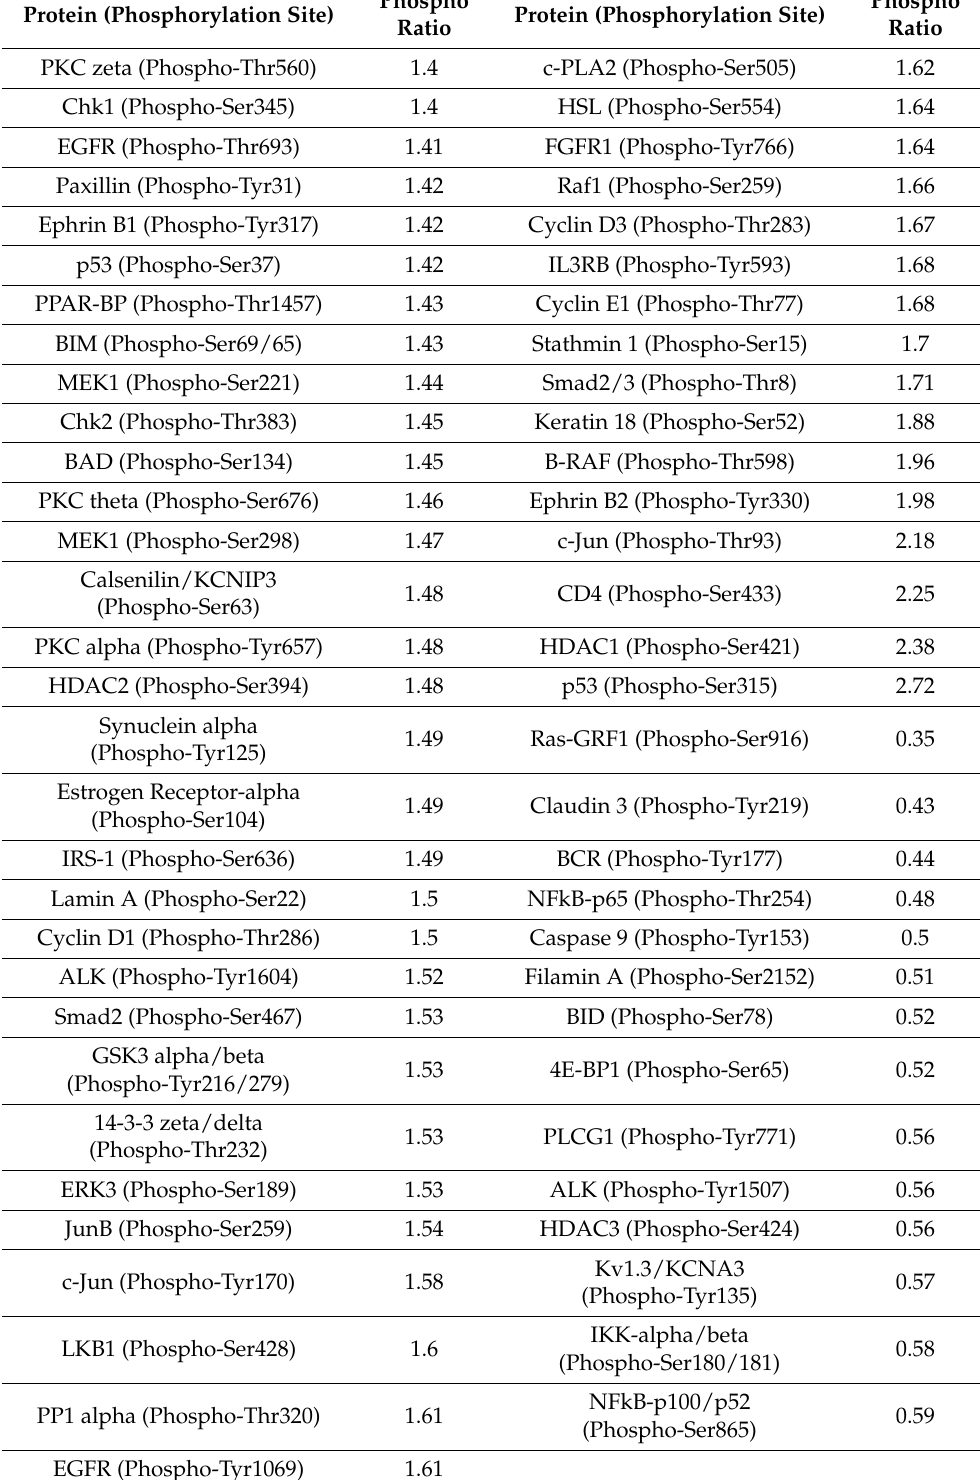
Table 1. Phospho-ratios between PF-3758309-treated and DMSO-treated 24ST1NLESG cells deter- mined from Phospho Explorer Antibody Array data. The ratio is equal to the signal intensity of the Phospho site-specific antibody over the signal intensity of the site-specific antibody. Phospho-ratios of an absolute fold change > 1.4 or <0.4 were included in the